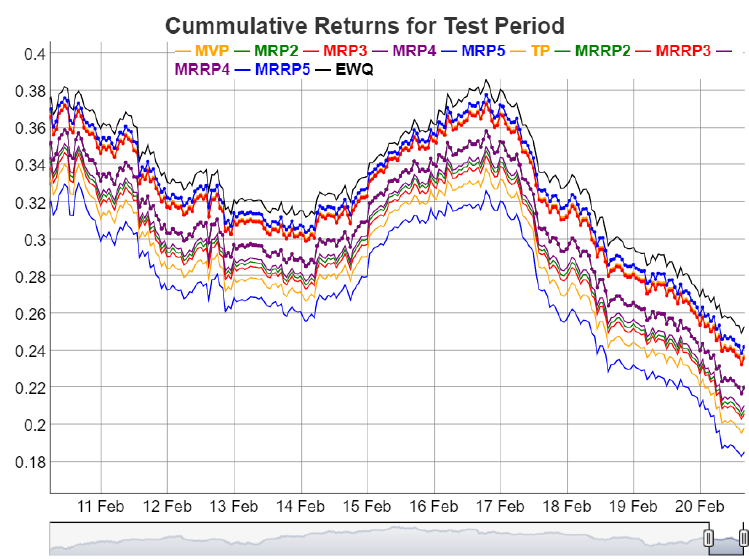
Figure 17. Cumulative returns of Cryptocurrencies (Group 1).